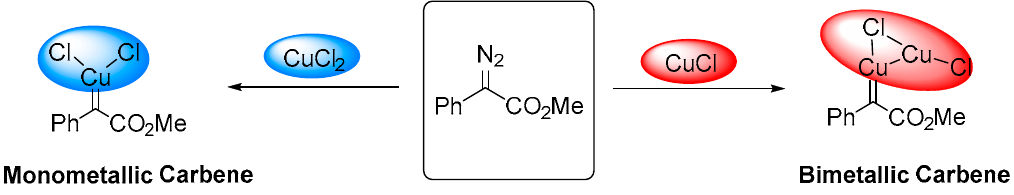
Figure 1. The reactions of the formation of the monometallic and bimetallic Cu carbenes [64].